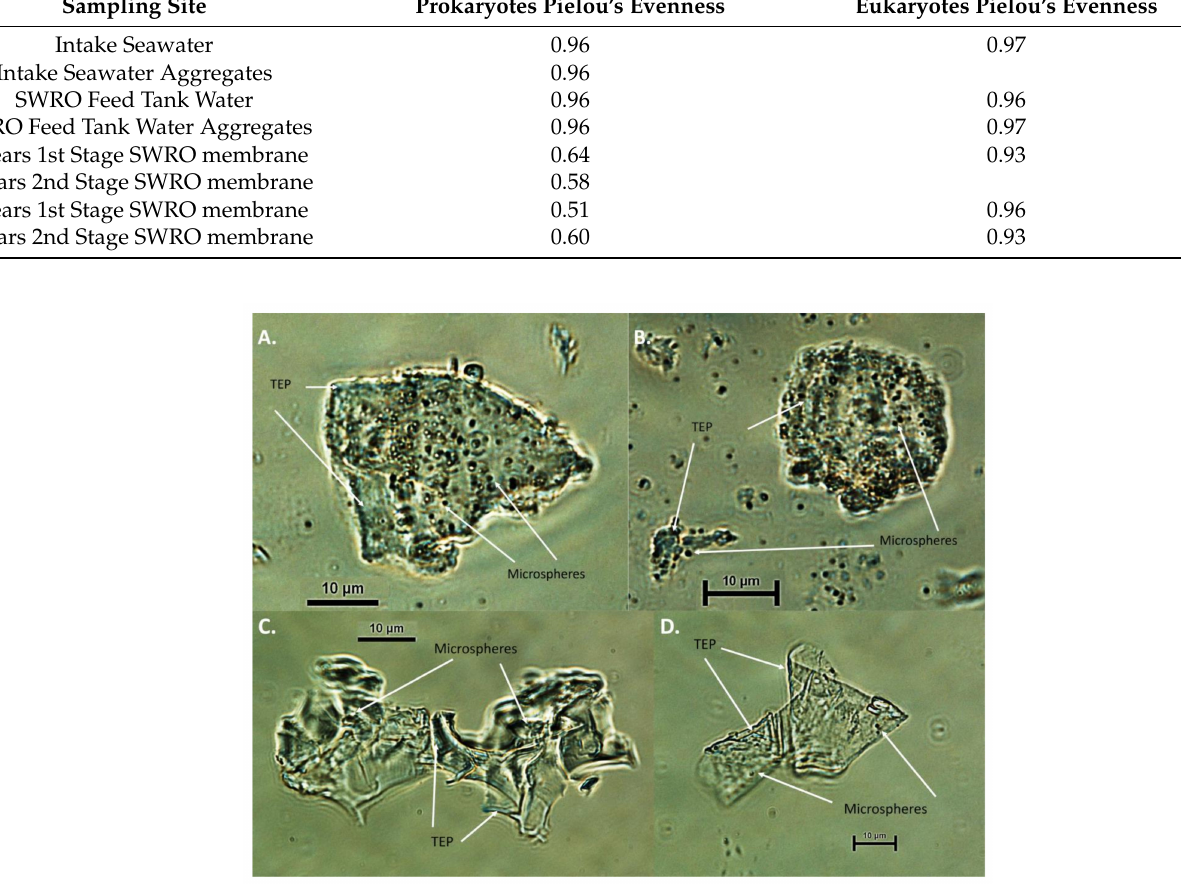
Figure 4. Microscopy of alcian blue stained aggregate samples, formed in the Penneshaw desalination plant. ( A , B ) Aggregates formed in the intake seawater and ( C , D ) aggregates formed in the SWRO feed tank water fluoresced cells (Figure 5A,B). The larger, brighter cells could be attributed to bacteria within the aggregates, with the smaller-sized particles, denoting a diffusion of the eDNA into the EPS surrounding the aggregates. The aggregate sample formed in the SWRO feed tank water displayed uniformity in the coverage of eDNA, with more bacteria cells visible in the aggregates. Similarly, there is also the smaller-sized particles evident, surrounding the bacteria cells (Figure